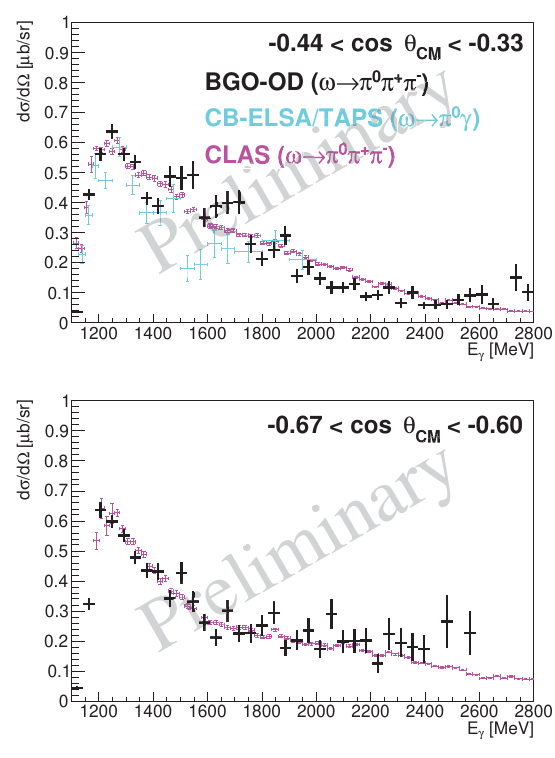
Figure 6. Preliminary γ p → ω p di ff erential cross sections iden- tified via the mixed charge decay, ω → π + π − π 0 (black points). For comparison, data from Dietz et al. [26] and Williams et al. [27] are shown in blue and magenta respectively. Analysis by G. Scheluchin